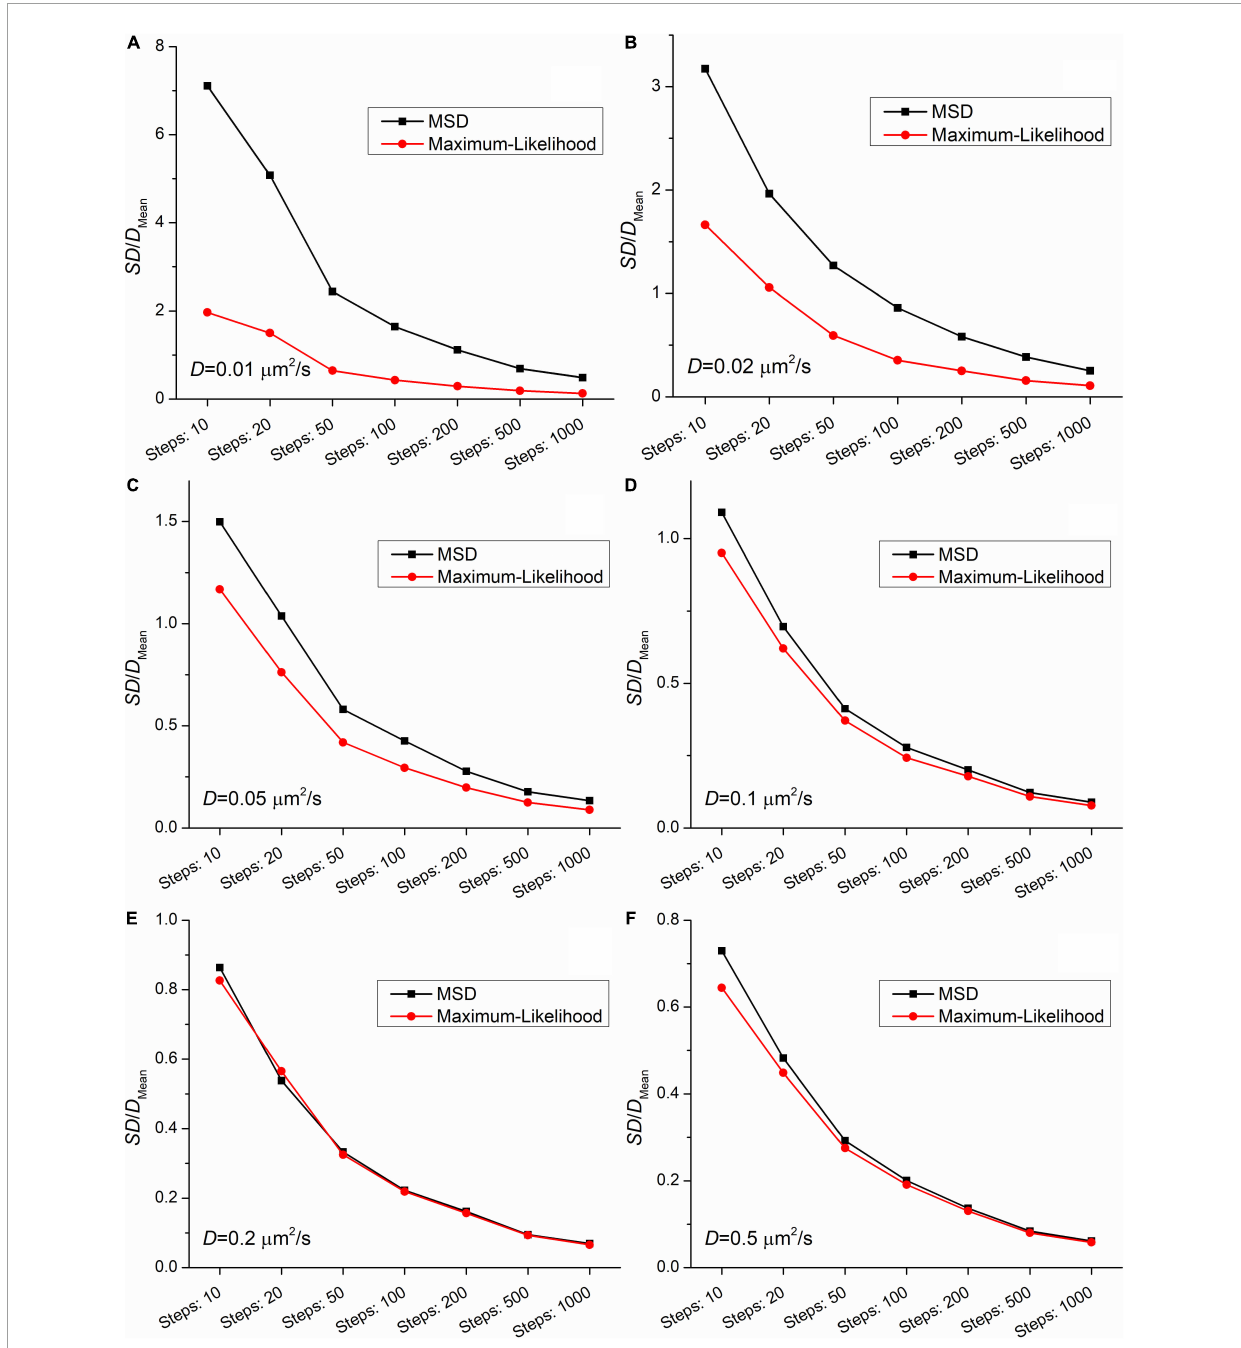
FIGURE3 The coefficients of variation (the ratio of the SD and the mean from Figure 2 ) as a function of the length of trajectories. The diffusion coefficients for the simulation were: (A) 0 . 01 µ m 2 / s , (B) 0 . 02 µ m 2 / s , (C) 0 . 05 µ m 2 / s , (D) 0 . 1 µ m 2 / s , (E) 0 . 2 µ m 2 / s , (F) 0 . 5 µ m 2 / s .